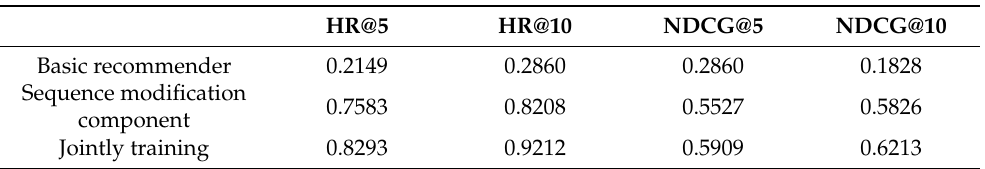
Table 6. The recommended results after the basic model training, the sequence modification compo- nent, and the joint